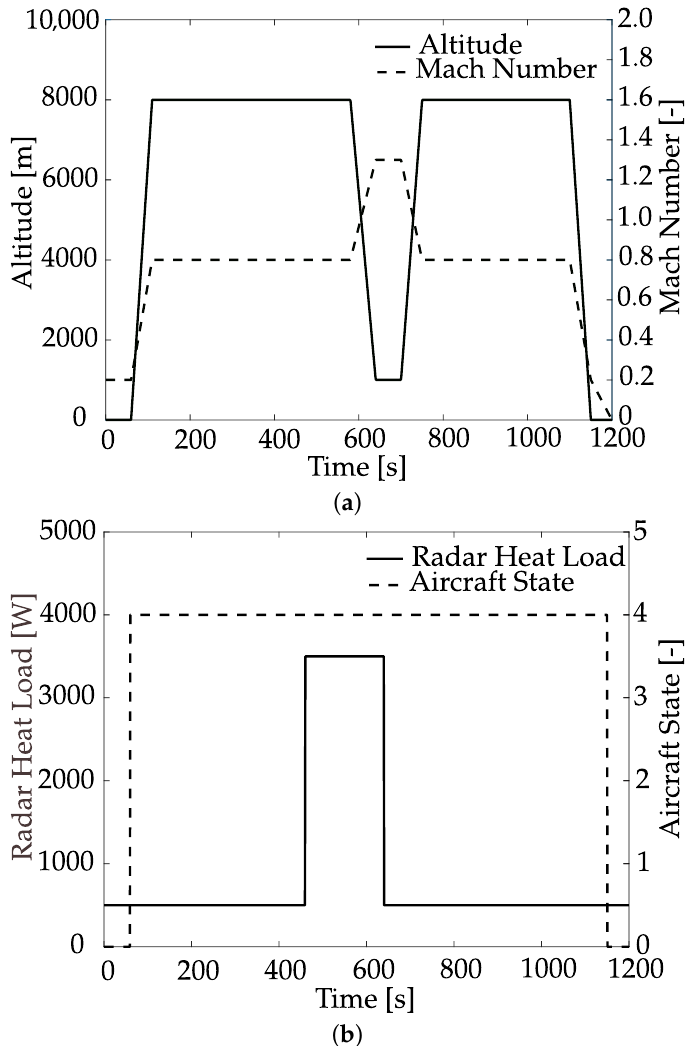
Figure 6. Boundary conditions corresponding to the specified OpsCon mission profile: ( a ) altitude and Mach number of the OpsCon mission profile; ( b ) heat load exerted by the application example radar component during the OpsCon mission. The radar here can operate in two different discrete modes: a stand-by mode corresponding to 500 W of power and an active mode corresponding to 3500 W. The dashed line represents the SW input signal AircraftState which indicates whether the aircraft is situated on the ground ( AircraftState = 1) or if it is airborne ( AircraftState =